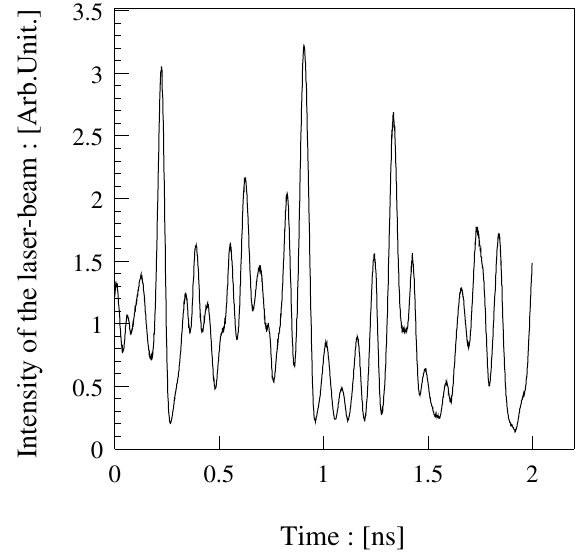
FIG. 20. Time distribution of the laser beam by the numerical